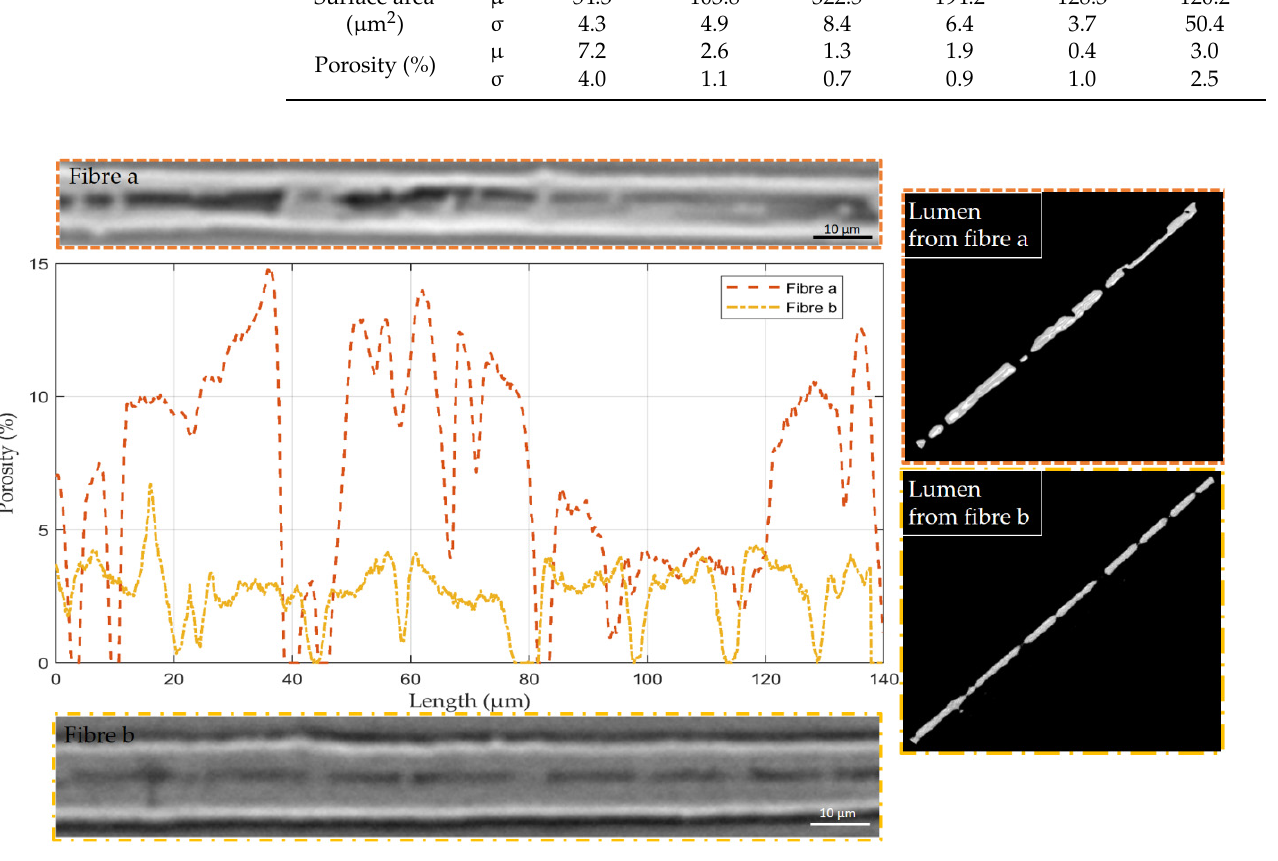
Figure 10. Porosity profile along two flax fibres “a” and “b”, corresponding longitudinal cross-sections of the fibres and 3D views revealing the internal lumen after image processing (right).